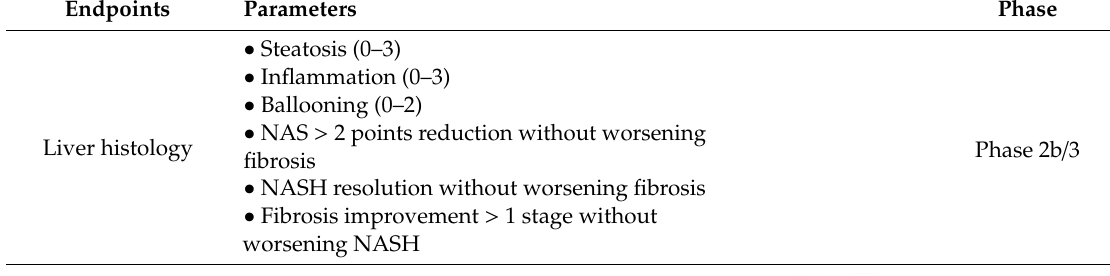
Liver histology